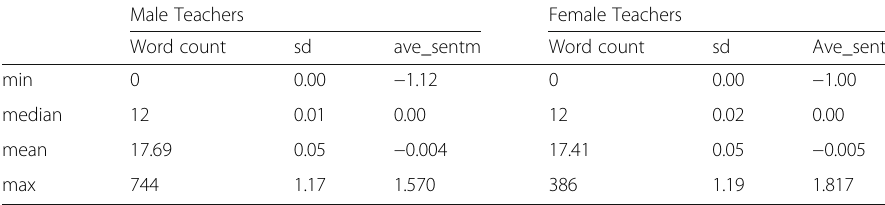
Table 2 Summary of the sentiment scores across the data by gender